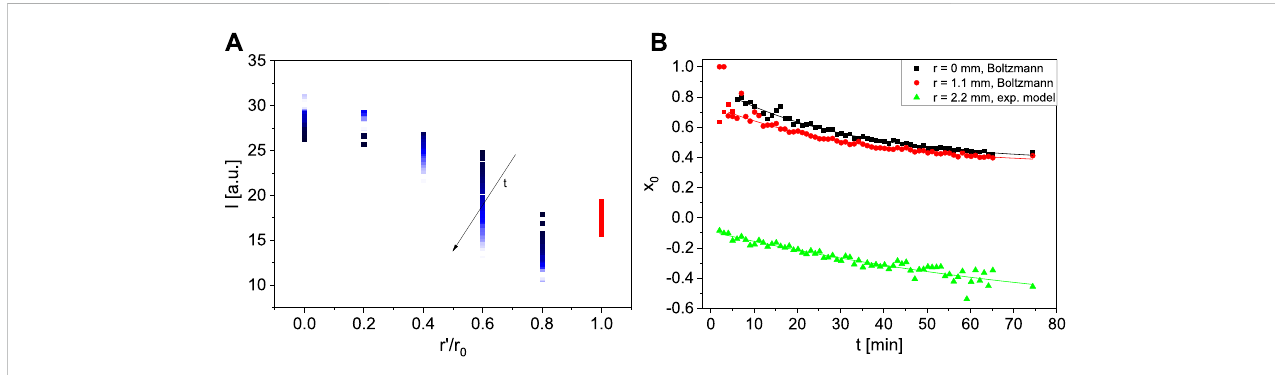
FIGURE 5 Three-stepdataprocessing:Thenormalized r ′ -pro fi leswereobtainedbyaveragingoftheMRintensity I overtheangleleadingtothepro fi les I ( r ′ / r 0 ),here on the example of the center channel (A) , implicitly as a function of fi ltration time t . These pro fi les were modelled by a sigmoidal Boltzmann function for the center channel and the channel at r = 1.1 mm and an exponential function for r = 2.2 mm, respectively, leading to the corresponding fi t parameters as a function of t . Due to partial volume effects, the point directly at themembranes surface was excluded (red points in the left graph). (B) Subsequently, the time-critical parameters x 0 ( t ) were modelled by an exponential decay function, resulting in the typical times for deposit formation under the chosen conditions.